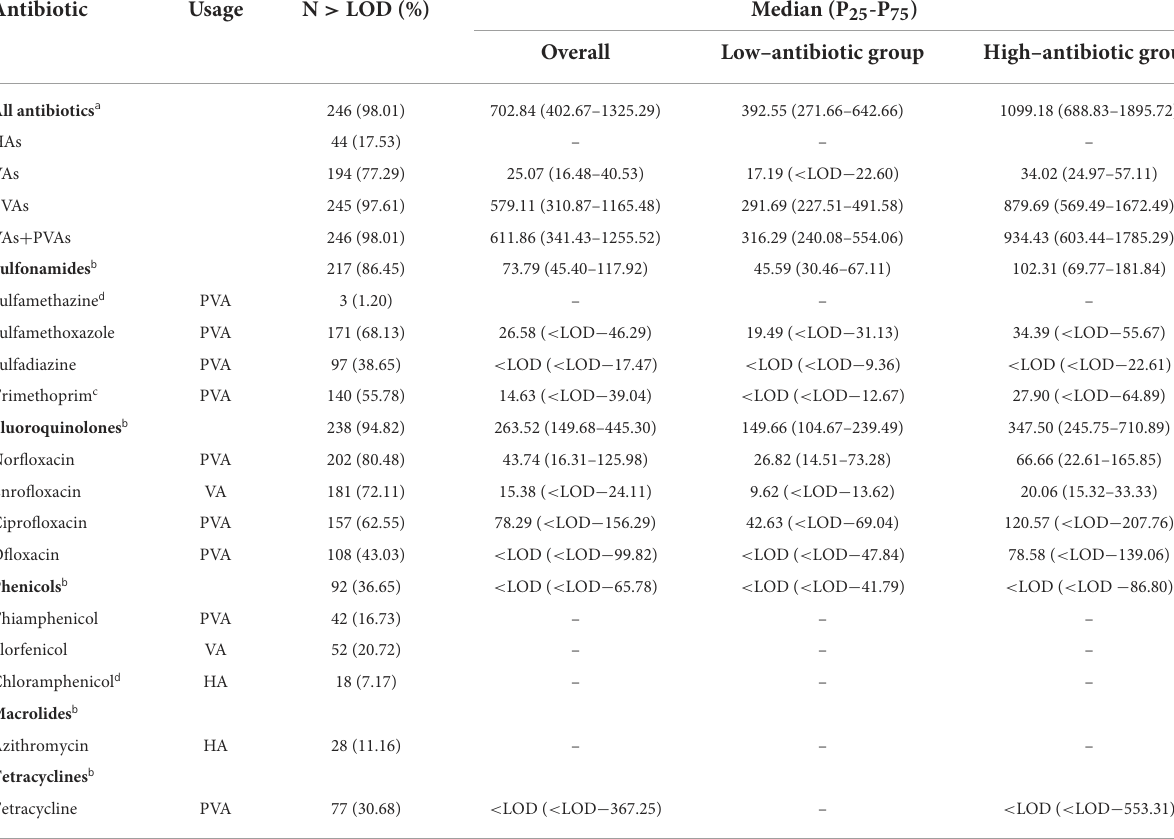
TABLE 2 Urinary creatinine-corrected concentrations (ng/g creatinine) of 13